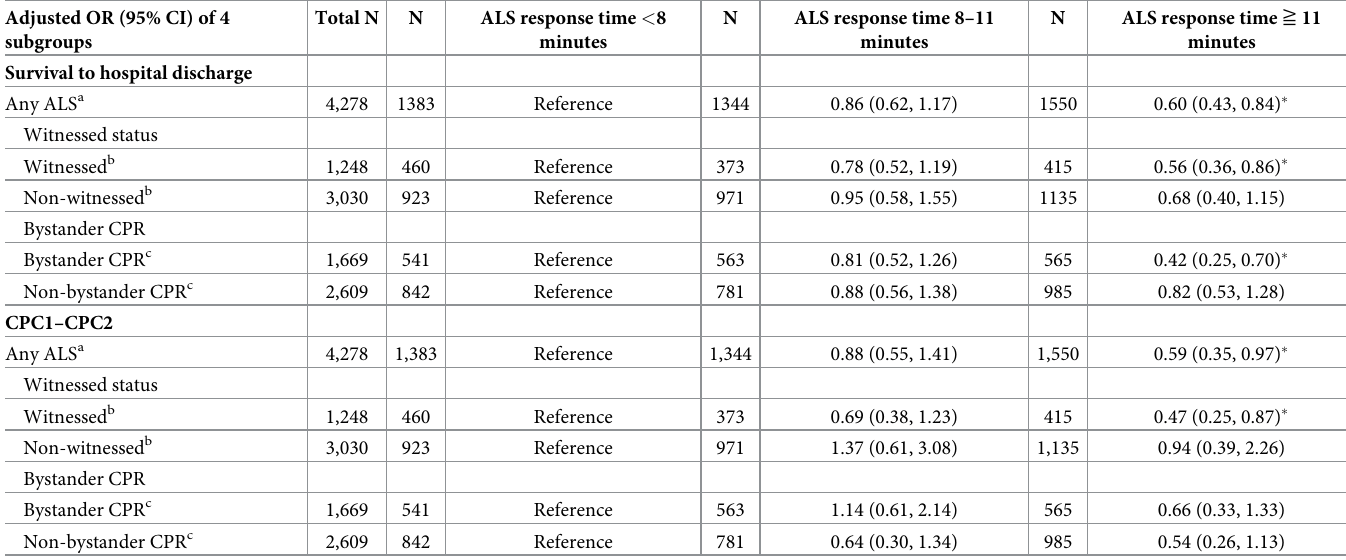
Table 3. Subgroups of multivariable logistic regression of survival to hospital discharge and neurological outcome in ALS response time interval (tertile). Adjusted OR (95% CI) of 4 subgroups